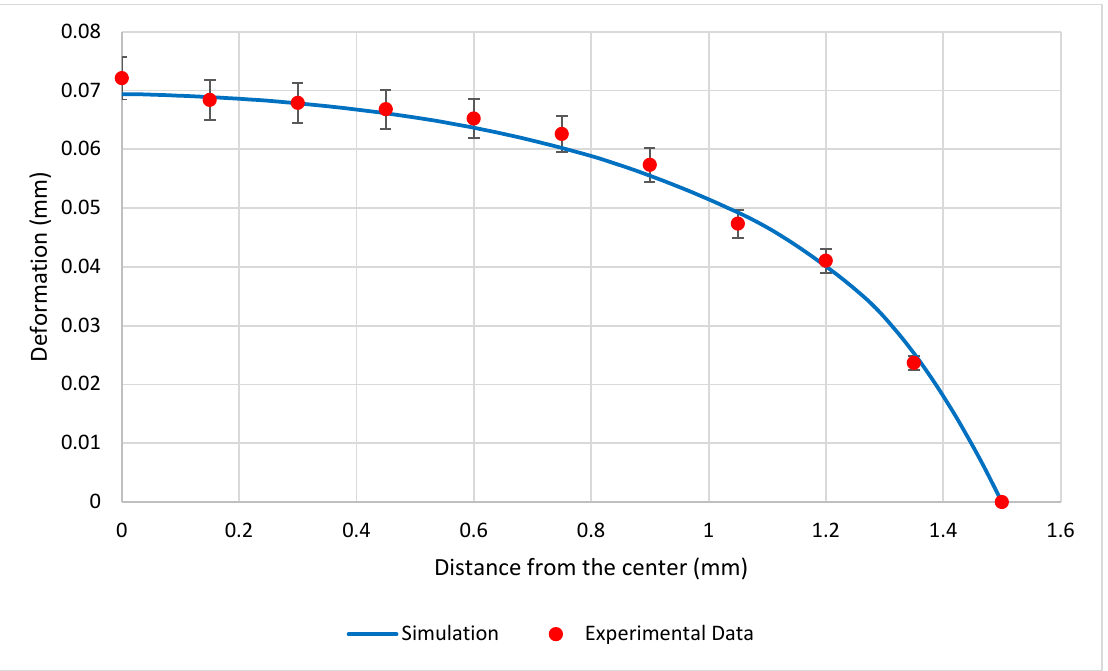
Figure 15. Comparison of the simulated transverse deformation profile to experimental results.